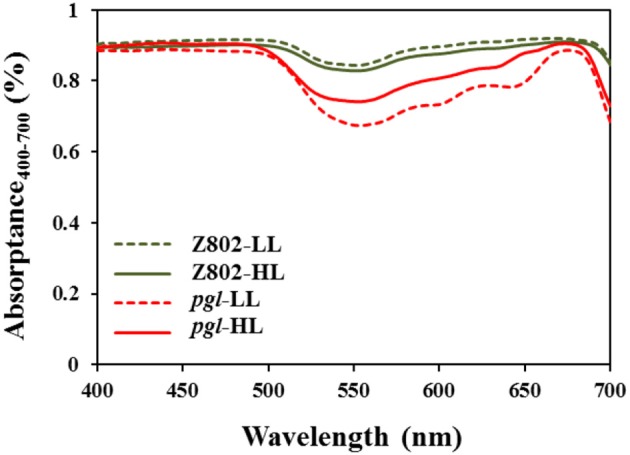
Leaf spectral absorptance rates of leaves of Z802 and pgl under low (LL) and high light treatment (HL).